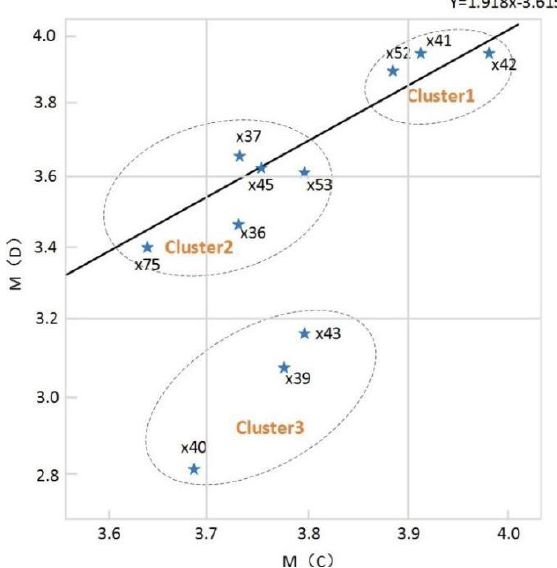
Figure 5. Clusters of greenness